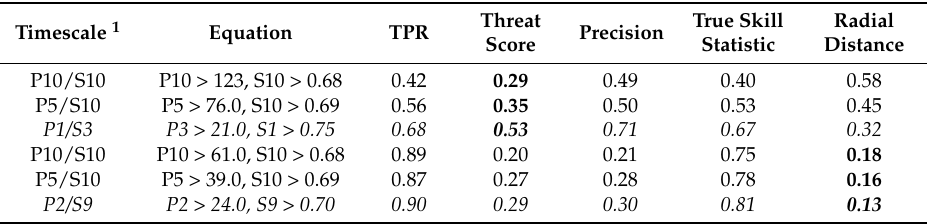
Table 2. Selected iterations of different threshold formats for the City of Portland, illustrating improved performance for different skill metrics. Skill metric used for optimization is in bold text, optimal threshold equation and statistics for the two different optimizations are italicized